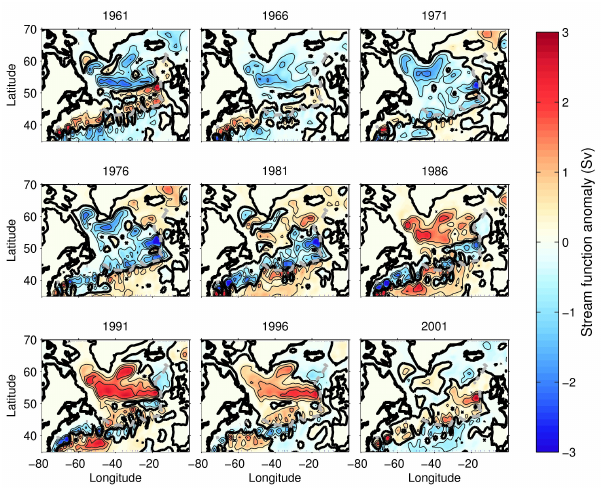
Figure 10. As Fig. 3 but for modelled LSW thickness anomaly (m). Fig. 10. As Fig. 3 but for modelled LSW thickness anomaly